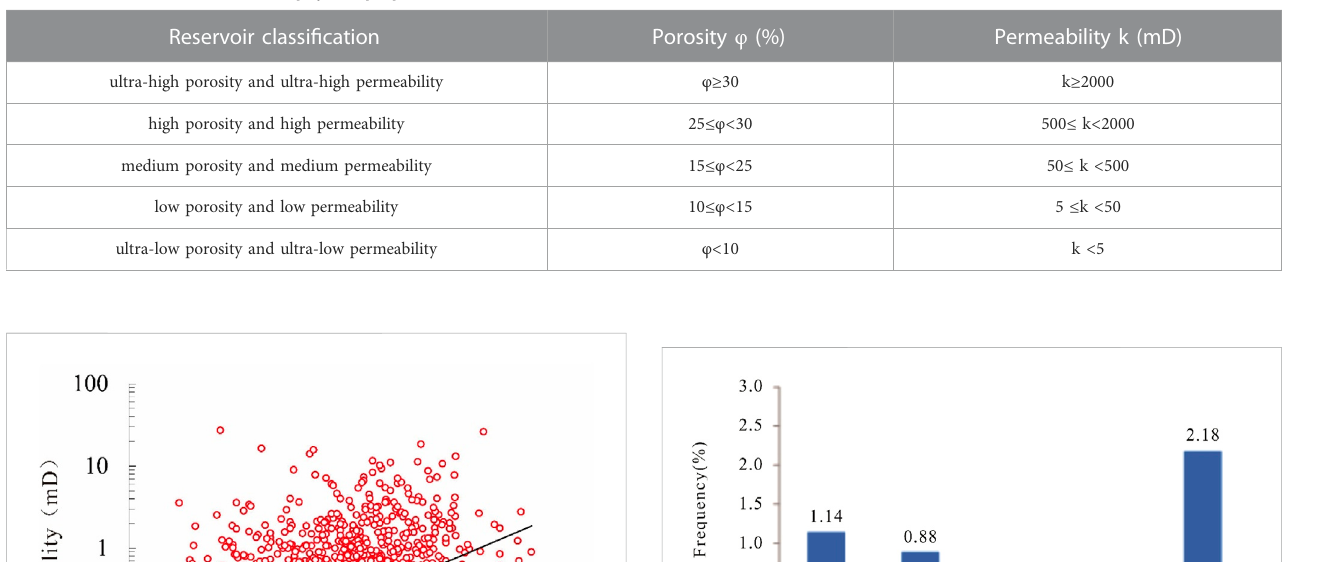
TABLE 1 Classi fi cation standards for physical properties of clastic rock reservoirs.